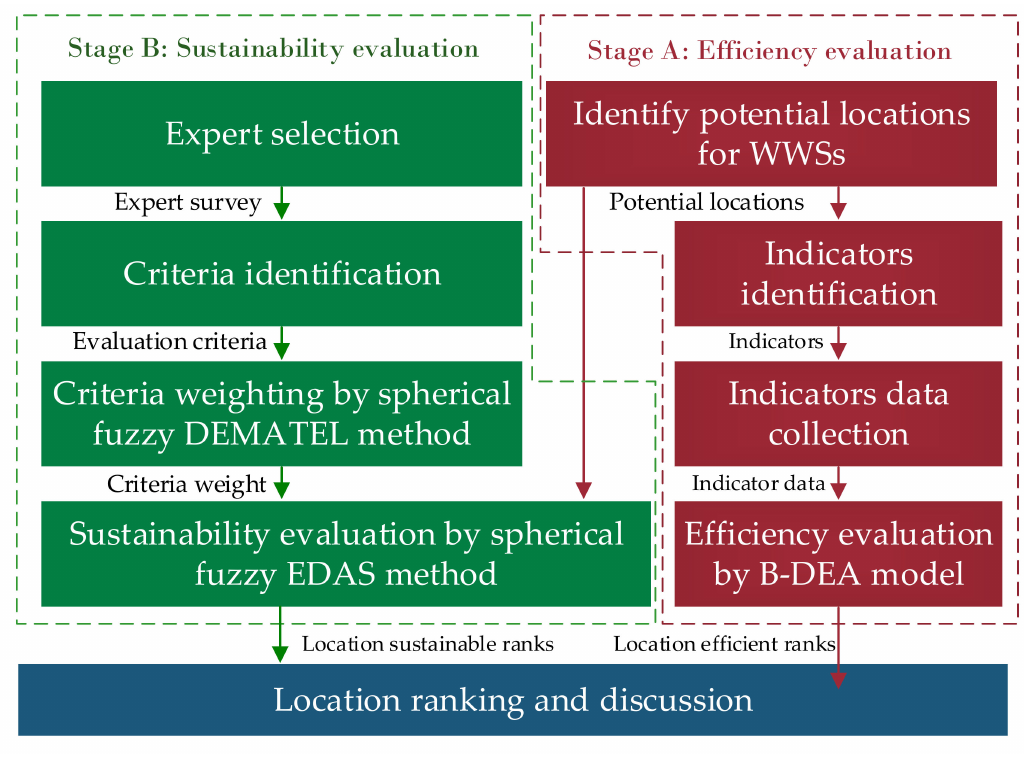
Figure 1. The proposed